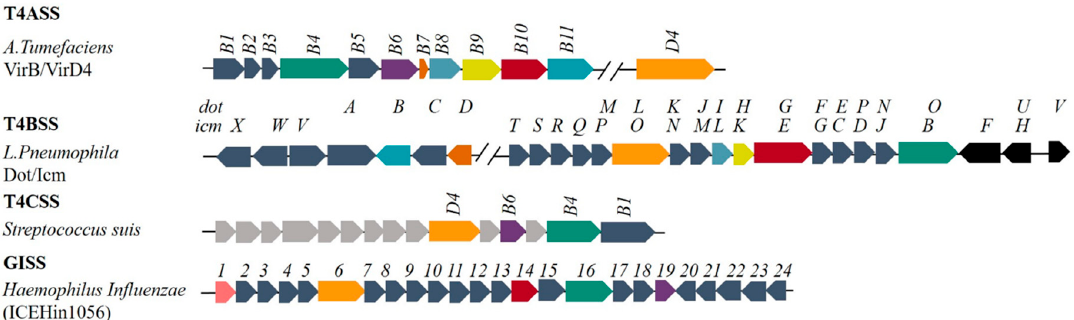
Figure 1. Composition of different T4SSs and homology comparison. Blocks of the same color (green, purple, red, orange, deep orange, celadon, cyan and yellow) represent homologous proteins; light grey blocks in T4CSS represent proteins of unknown function.